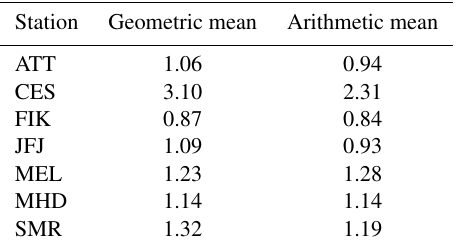
Table 3. Comparison of geometric to arithmetic mean values of the ratios of predicted and measured CCN 0 . 5 number concentrations based on calculations with the composition-derived κ IA + OA − BC . Station Geometric mean Arithmetic mean ATT 1.06 0.94 CES 3.10 2.31 FIK 0.87 0.84 JFJ 1.09 0.93